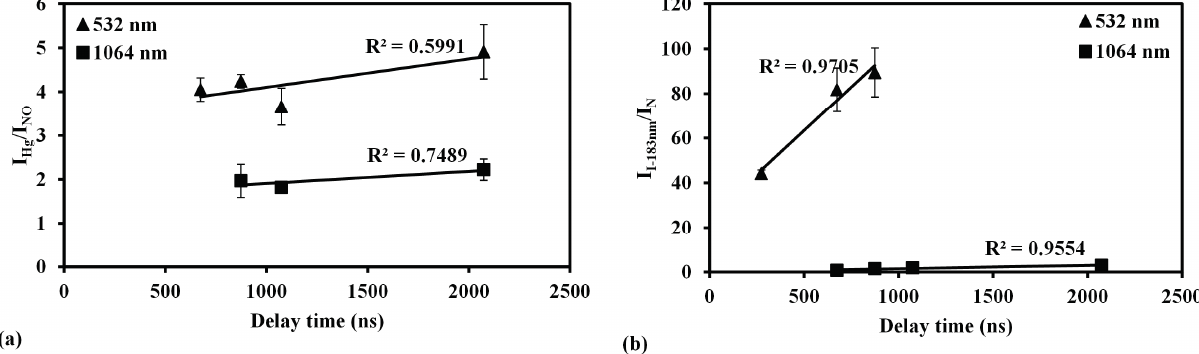
Figure 11. Comparison of I Hg /I NO and I I-183nm /I N dependence on delay time between 1064 nm and 532 nm laser irradiation using LIBS. ( a ) The ratio of I Hg /I NO . Conditions: ns 532 nm and 1064 nm laser irradiation, power 400 mJ/p, beam diameter 9 mm, pressure 700 Pa, gate width 30 μ s; ( b ) The ratio of I I-183nm /I N . Conditions: ns 532 nm and 1064 nm laser irradiation, power 400 mJ/p, beam diameter 9 mm, pressure 1300 Pa, gate width 30 μ